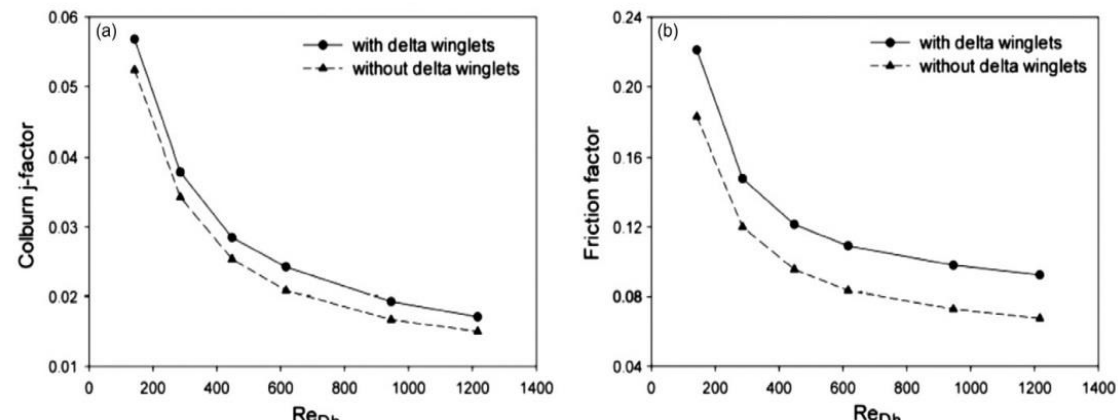
Figure 16: Comparison of (a) the Colburn j-factor and (b) the friction factor for the baseline geometry without delta winglets and the compound design with delta winglets [26].